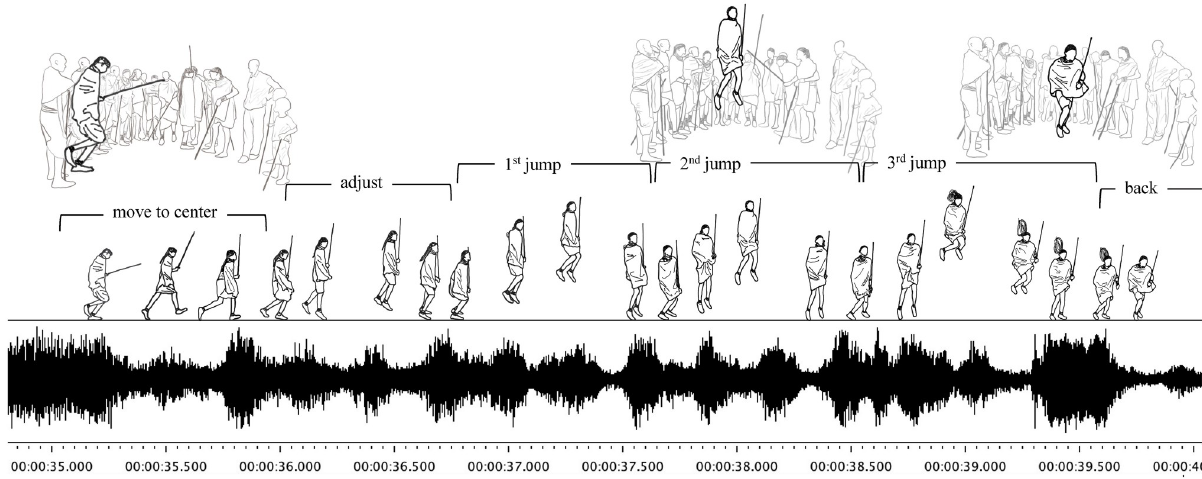
Fig 1. Illustration of one jump session following the